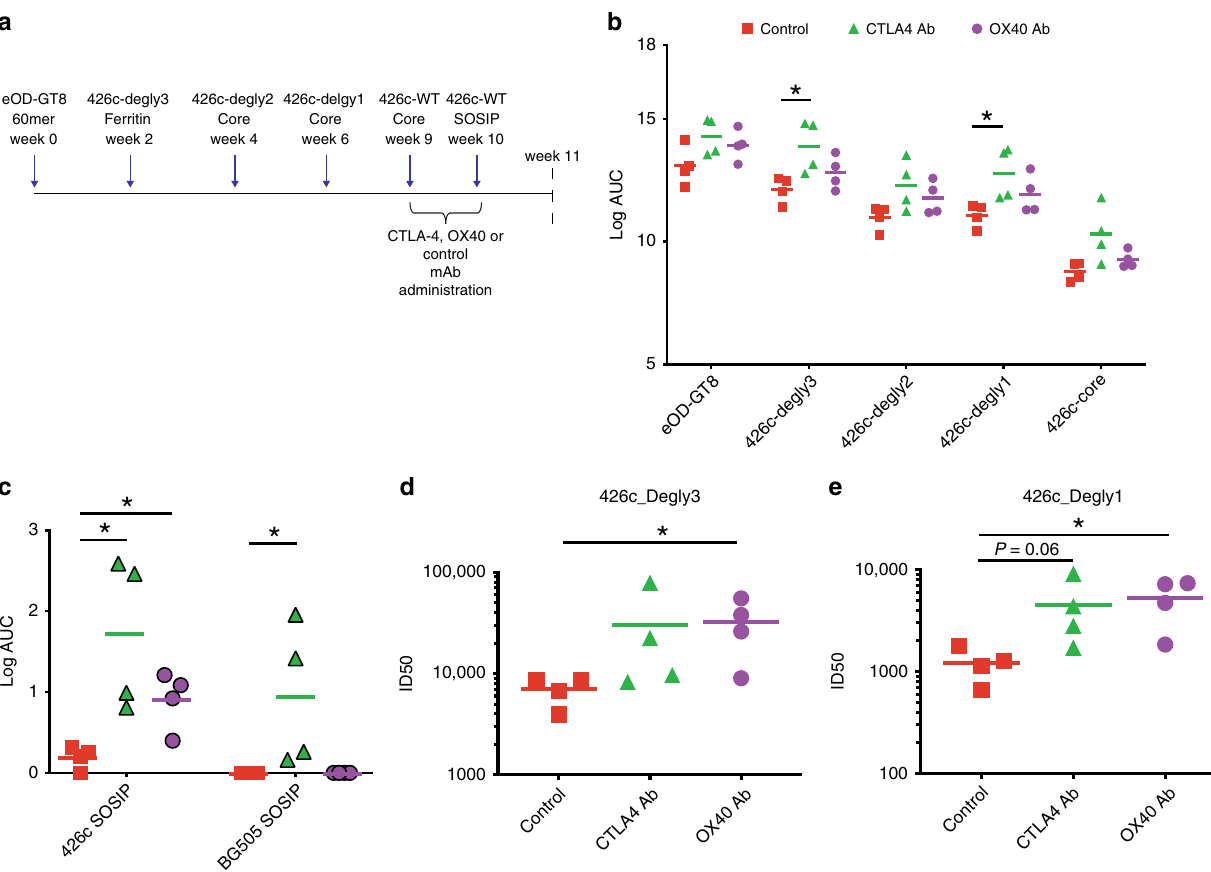
Fig. 5 Co-administration of CTLA-4 or OX40 with precursor targeting vaccine in VRC01 knock-in mice. a Vaccination protocol for immunization of four groups of VRC01 precursor knock-in mice with sequential germline-targeting vaccine regimen with co-administration of CTLA-4 blocking (CTLA4 Ab; n = 4) or OX40 agonist (OX40 Ab; n = 4) or control ( n = 4) antibodies. Additionally, we included a no co-administration group ( n = 2) as control. b , c Plasma antibody titers at week 11 of ( b ) binding to sequential vaccine proteins by ELISA measured by Log area under the curve ( c ) binding to autologous (426c) and heterologous (BG505) SOSIP trimers by ELISA measured by Log area under the curve. d , e Plasma antibody neutralization of ( d ) 3 glycan deleted 426c virus (426c_Degly3) and ( e ) N276 glycan deleted (426c_Degly1) at week 11 measured in the TZM-bl assay. Inhibitory dilution at 50% (ID50) graphed. Each dot represents a single animal and are colored based on the antibody treatment group (Control Ab, red; CTLA4 Ab, green; OX40 Ab, purple). * P ≤ 0.05, Wilcoxon – Mann – Whitney. Source data are provided as a Source Data fi